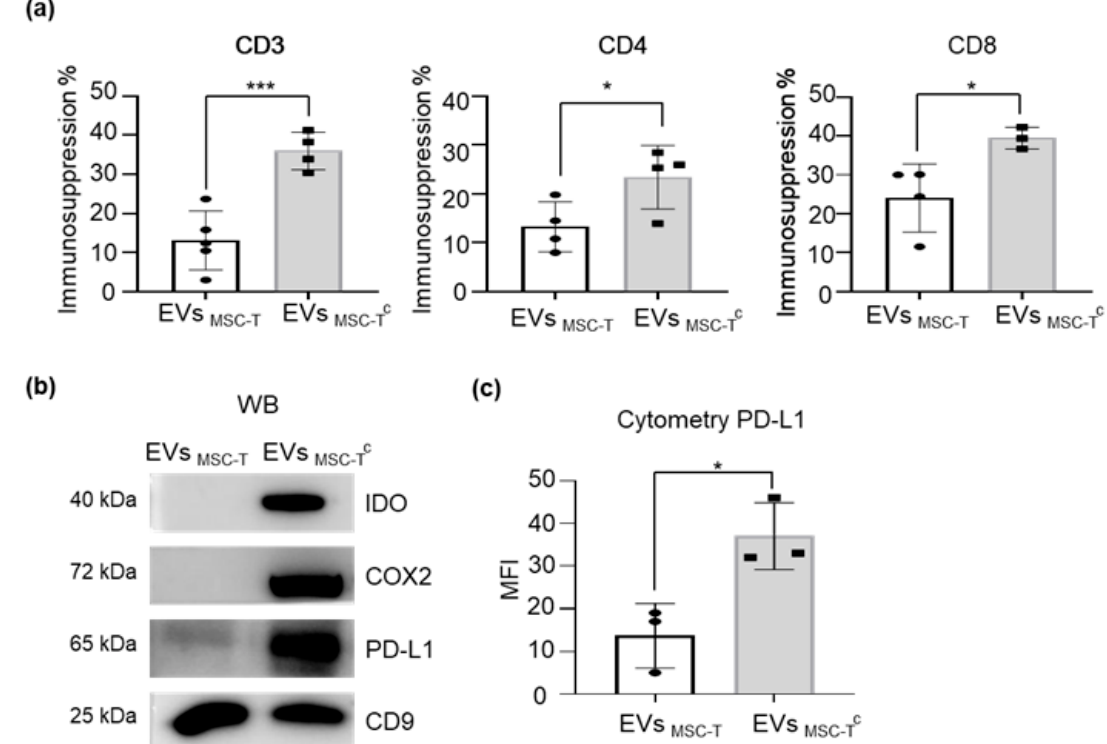
Figure 2. Conditioning results in an enhancement of the immunomodulatory capacity of EVMSC-T. ( a ) Peripheral blood mononuclear cells (PBMCs) were stained with CFSE and stimulated with anti-CD3 and anti-CD28 beads in the presence or absence of EVMSC-T or MSC-T c -derived EVs (EV MSC-Tc ). After 5 days, cells were stained with anti-CD3, anti-CD4 and anti-CD8 antibodies and proliferation of T-cell subsets was determined by flow cytometry measurement of CFSE dilution. Suppression (percentage) was calculated based on the expansion index. Graphs represent mean ± SD of four independent experiments. Unpaired t -test was used for statistics. ( b ) Representative Western blot of IDO, COX2 and PD-L1 protein expression levels. CD9 was used as a loading control. ( c ) PD-L1 protein expression level measured by flow cytometry using MFI geometric mean value of EV MSC-T and EV MSC-Tc stained with anti-PD-L1. Values are represented as relative to EVMSC-T geometric mean value. Graphs represent mean ± SD of three independent experiments. Paired t -test was used for statistics. * p < 0.05, *** p <